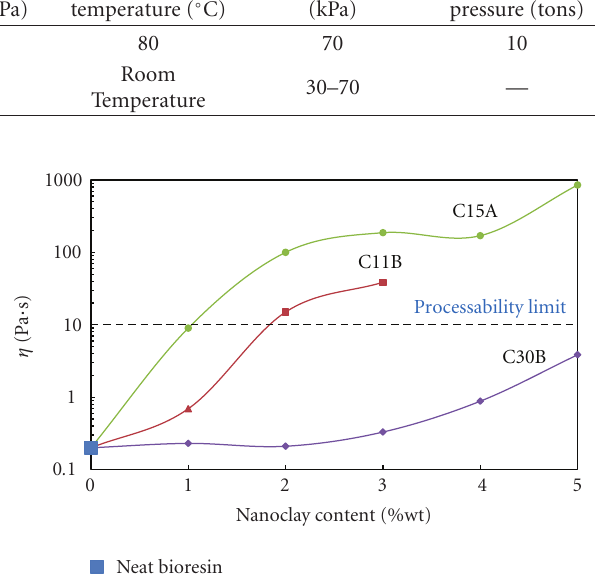
Figure 7: Viscosity at 23 ◦ C for various types of nanoclays and percentage. The dotted line indicates the maximum viscosity allowed for liquid composite molding.